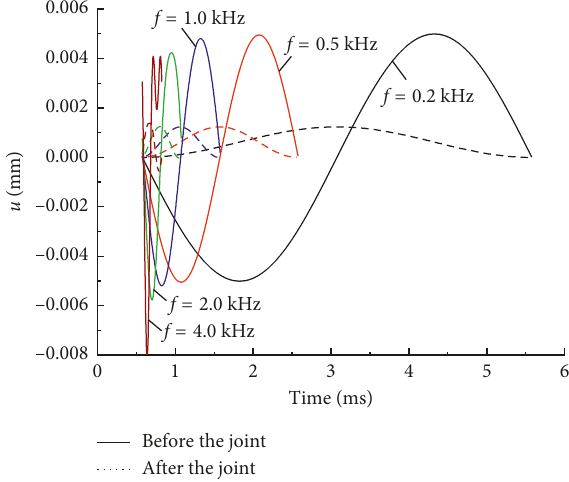
Figure 6: Waveforms recorded before and after the joint at x 2 . 0m with different frequencies.